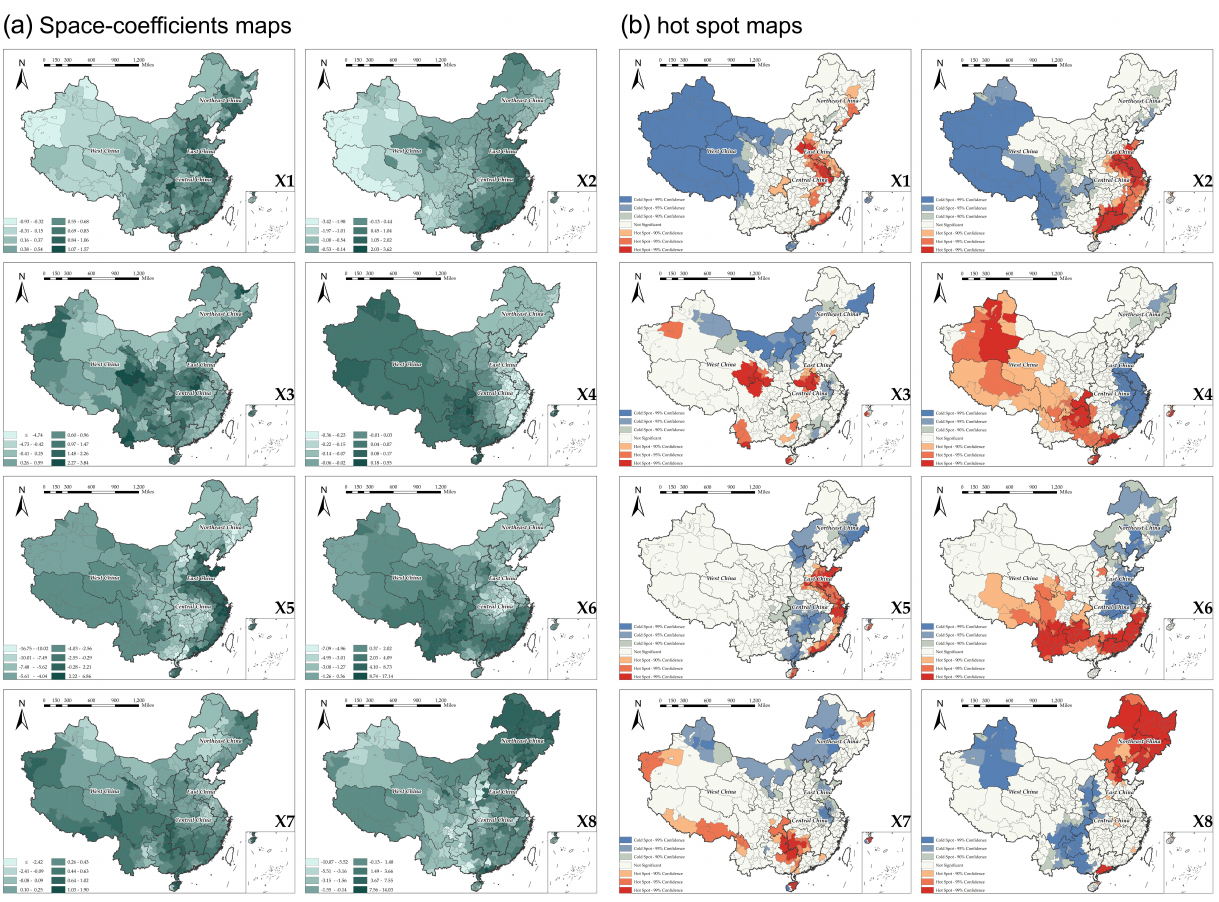
Figure 5. ( a ) Space-coefficients (SCs) maps (covariates’ spatial nonstationarity): spatially varying impacts of main drivers (X1–X8) on total tourism revenue at city level across China, and ( b ) hot spot analysis for SCs maps: X1—average wage of employed persons in urban units, X2—employment density of urban units, X3—GDP per capita, X4—population density, X5—nighttime light index, X6—slope, X7—NDVI, and X8—road network